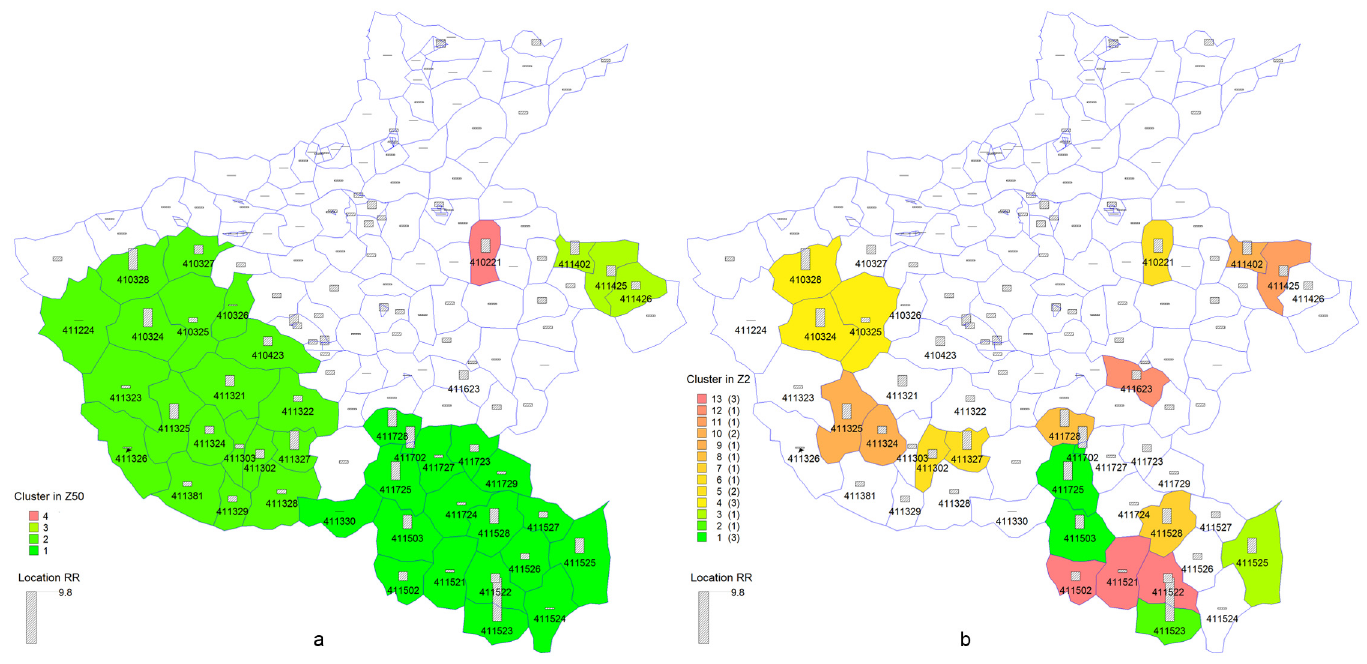
Fig 3. Incidence of measles in Henan in May 2009 and clusters detected with default (a) and selected maximum spatial cluster size using MCS-P (b). Administrative codes of 42 clustering counties are labeled. RR of each counties are presented as